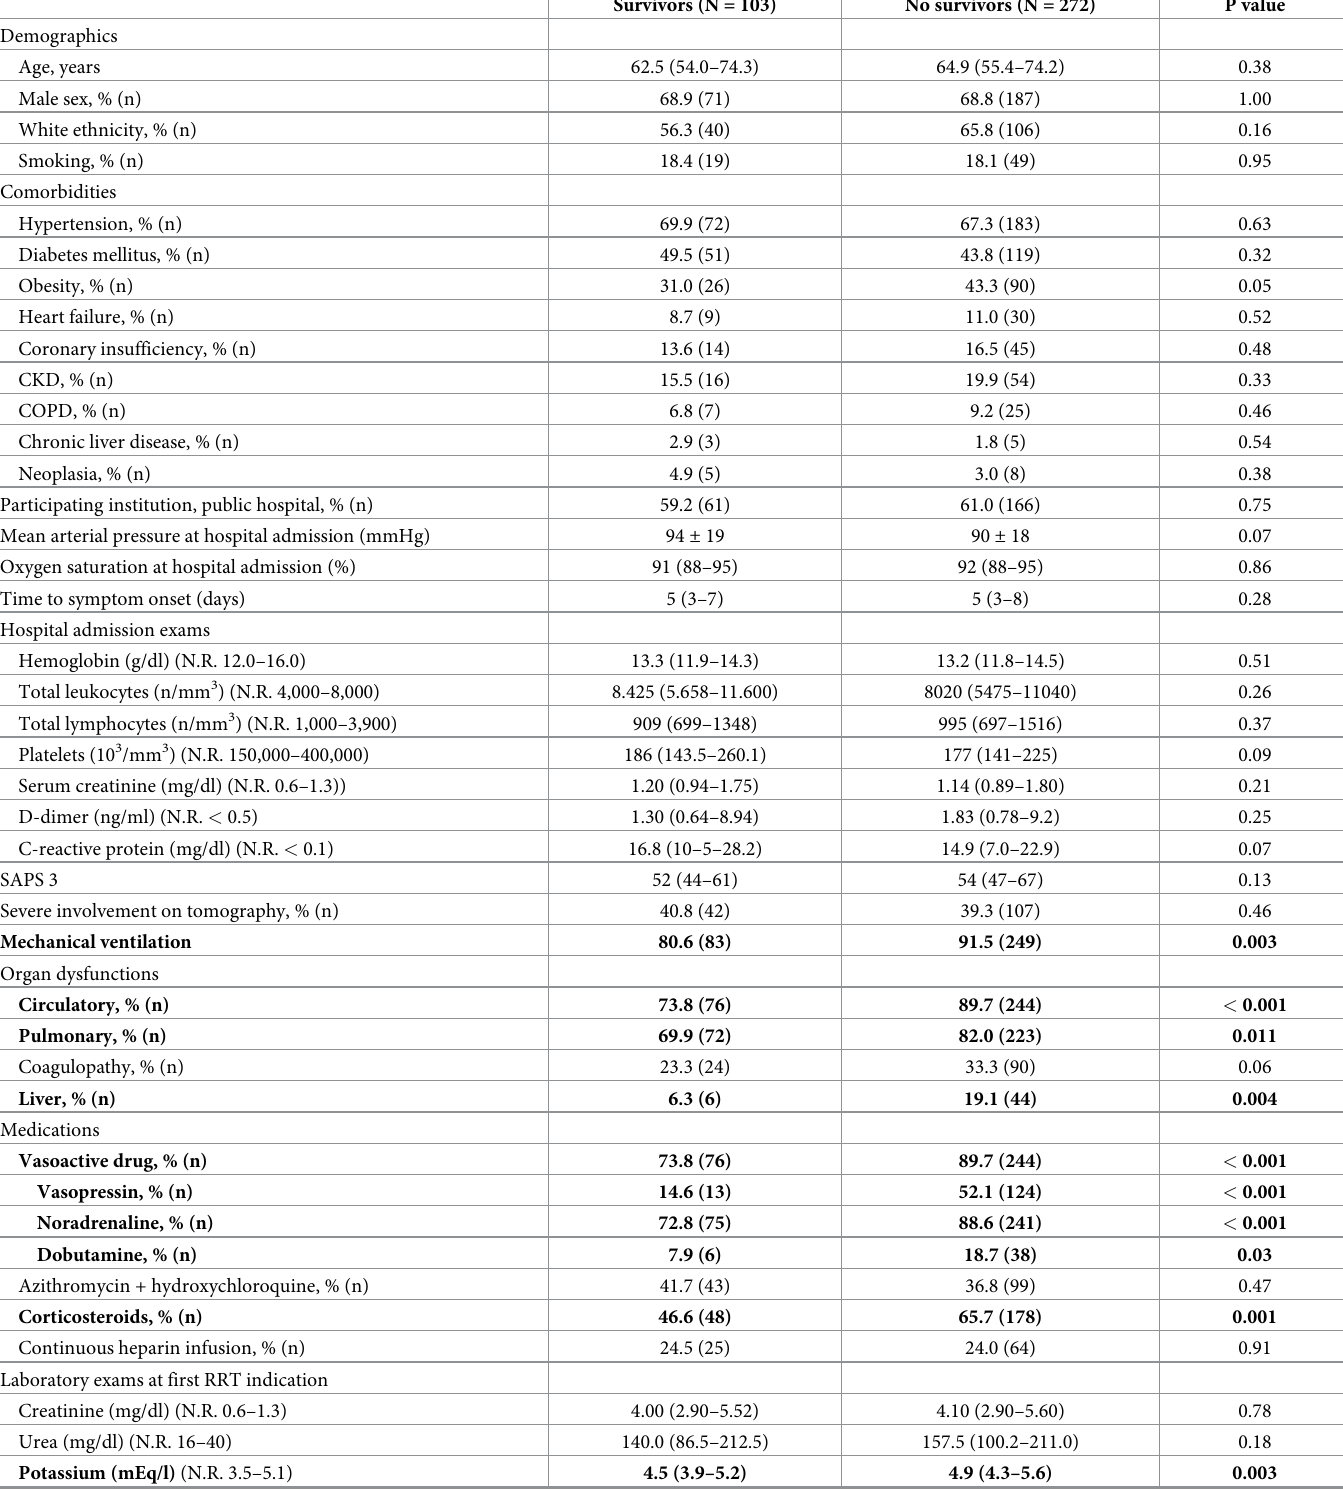
Table 3. Comparison between surviving and nonsurviving